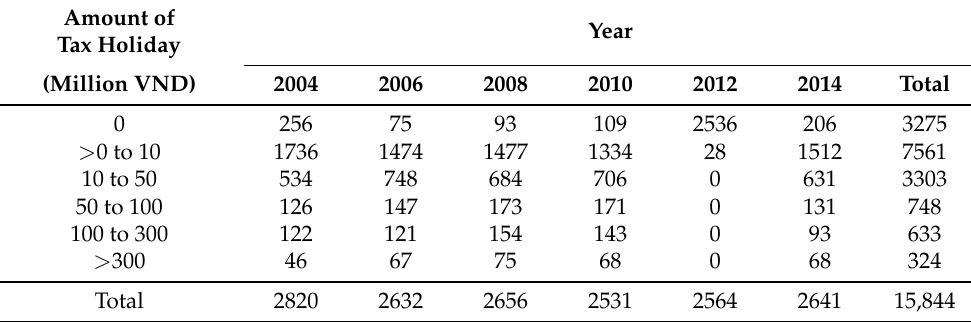
Table 6. Vietnamese SMEs’ tax holidays between 2005 and 2015 (Unit: Million